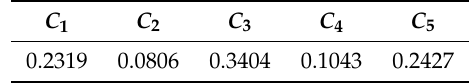
Table 10. The discount coefficient U C